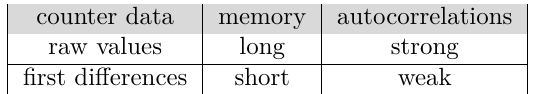
Table 1: Comparison of raw counter values and their first differences.